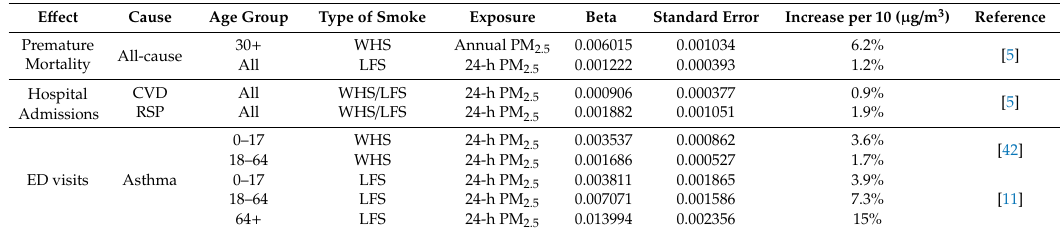
Table 1. Fine particulate matter (PM 2.5 ) dose-response functions selected for wood heater smoke (WHS) and landscape fire smoke